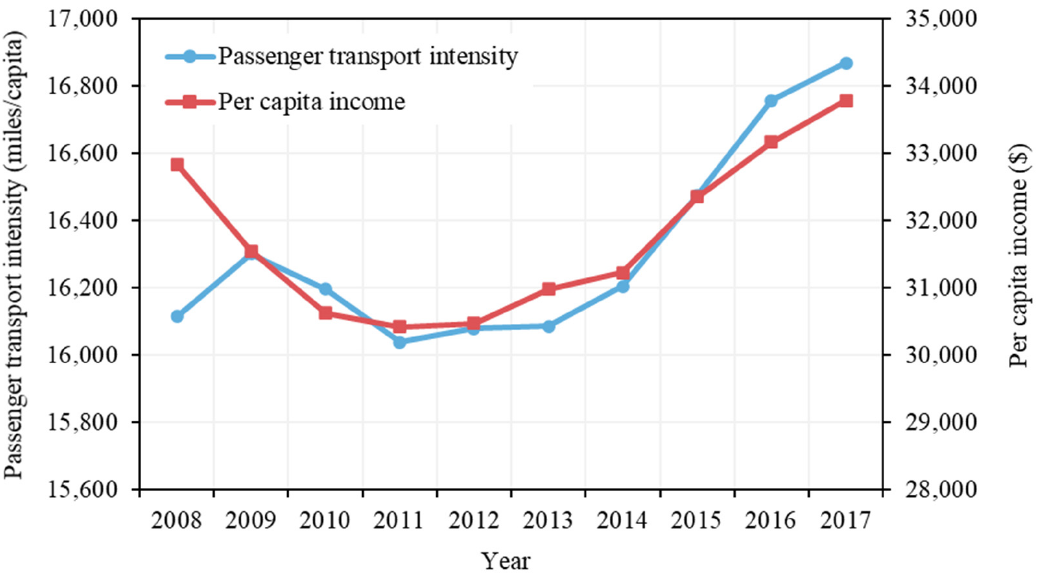
Figure 4. Passenger transport intensity and per capita income of the U.S. from 2008 to 2017. Negative